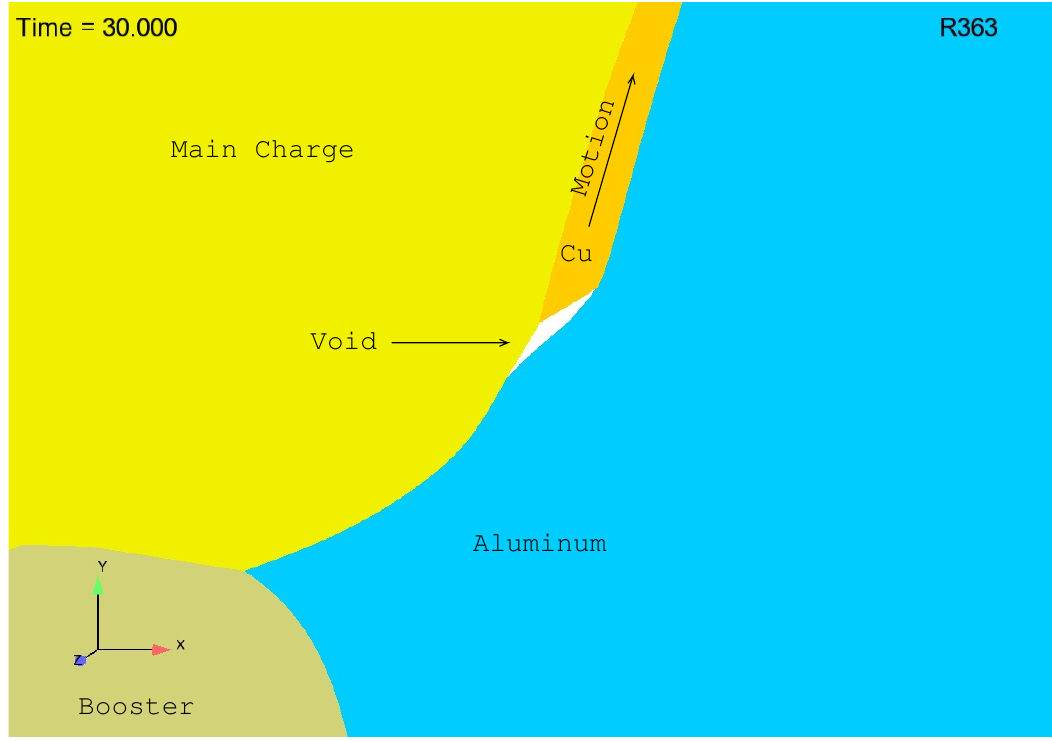
Figure 2. Initiation of a “void” at about 20 µ s.